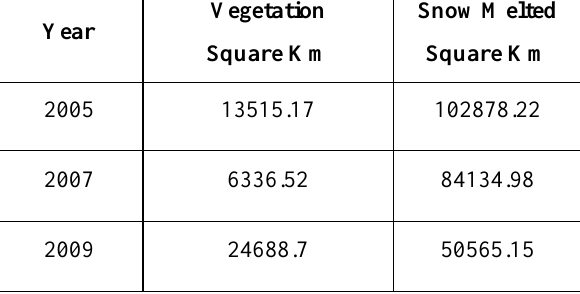
Table 2: Comparison of Vegetation and Snowmelt